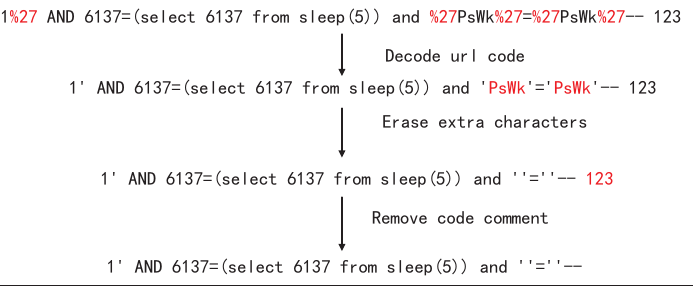
Figure 2. An example of data preprocessing.